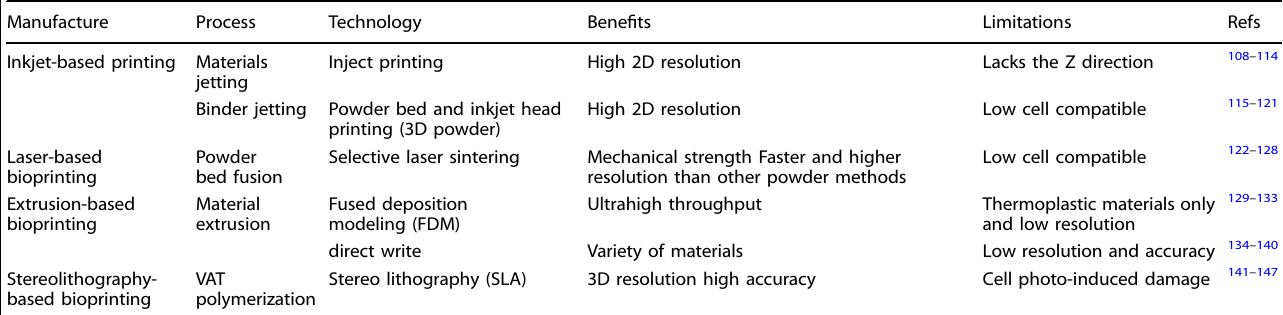
Table 1. Bioprinting technologies and their pros and cons according to ASTM standard F2792 107